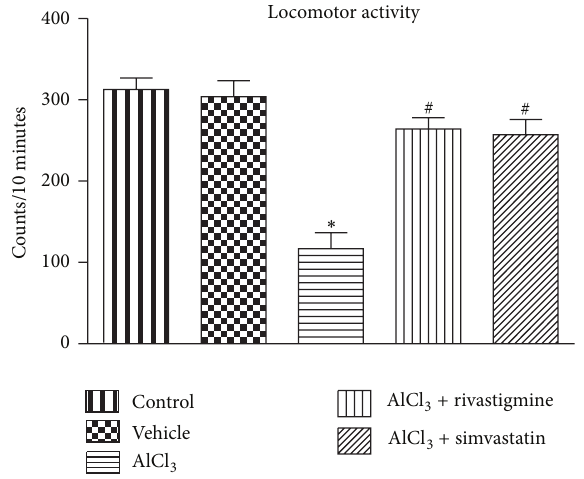
Figure 2: Effect of AlCl 3 and AlCl 3 + treatments on locomotor activity after treatment. Data are presented as mean ± SEM ( 𝑛 = 8 ). ∗ 𝑃 < 0.05 as compared to control group and # 𝑃 < 0.05 as compared to AlCl 3 treated group.